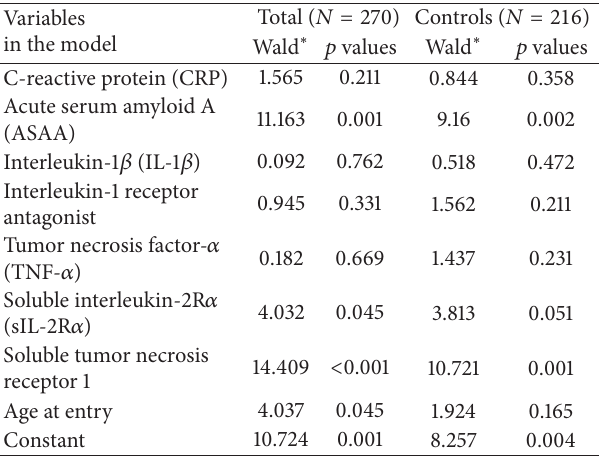
Table 2: Logistic regression model of sex outcome, including age and serum inflammatory biomarkers, but not IL-6 assayed only in